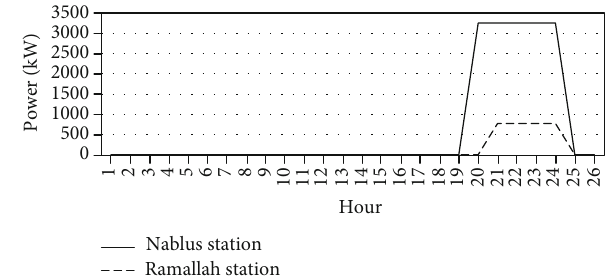
Figure 6: Charging demand for the fi rst